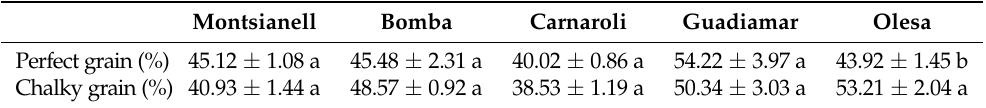
Table 2. Crystallinity percentages for the cultivars studied. Values are presented as mean ± SEM. Different letters within a cultivar indicate significant differences ( p < 0.05).